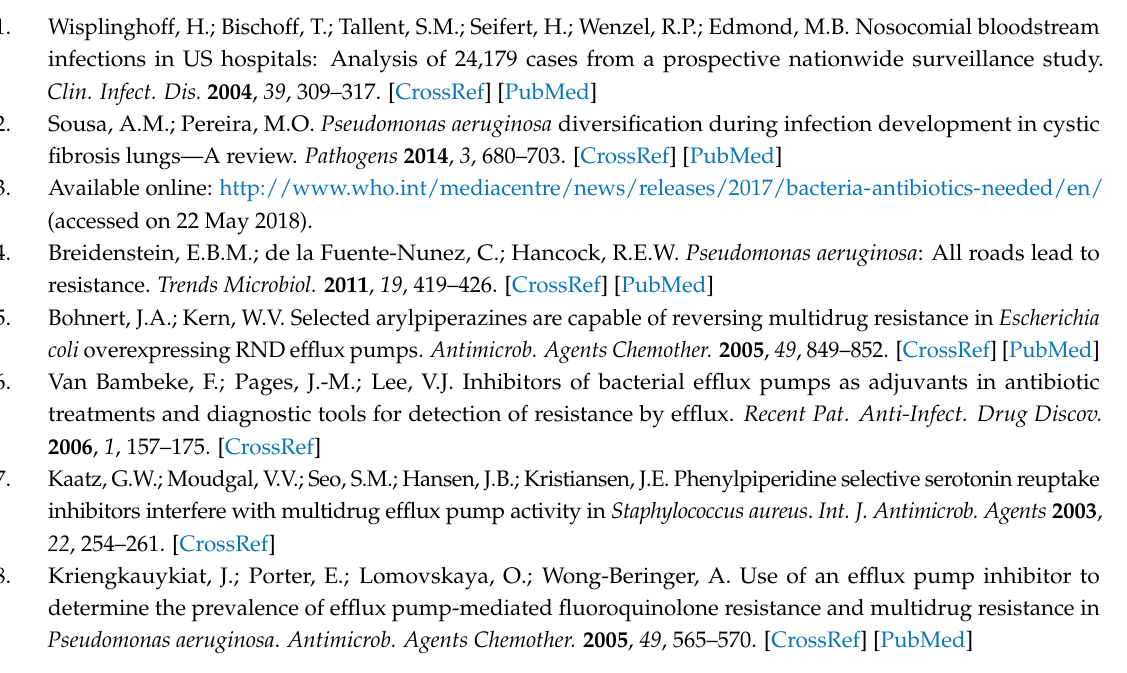
Table S1: antimicrobial susceptibility profile of P. aeruginosa clinical isolates used in this study. Author Contributions: F.S. supervised the studies. X.Y., Y.L., G.G.Z. and F.S. designed, performed, or supervised the biochemical assays. X.Y. wrote the original draft. R.D. and F.S. were involved in the writing-review and